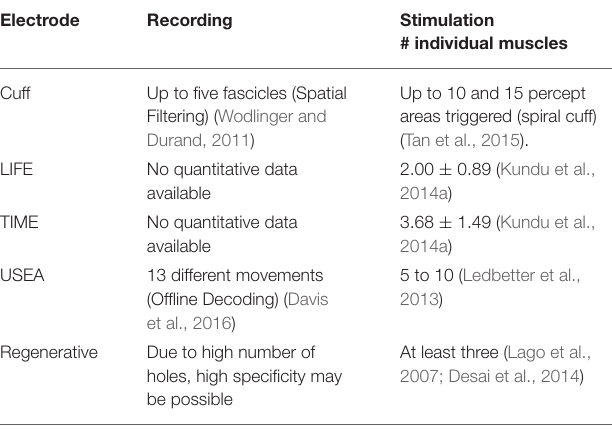
TABLE 2 | Comparison between the spatial resolution of the discussed